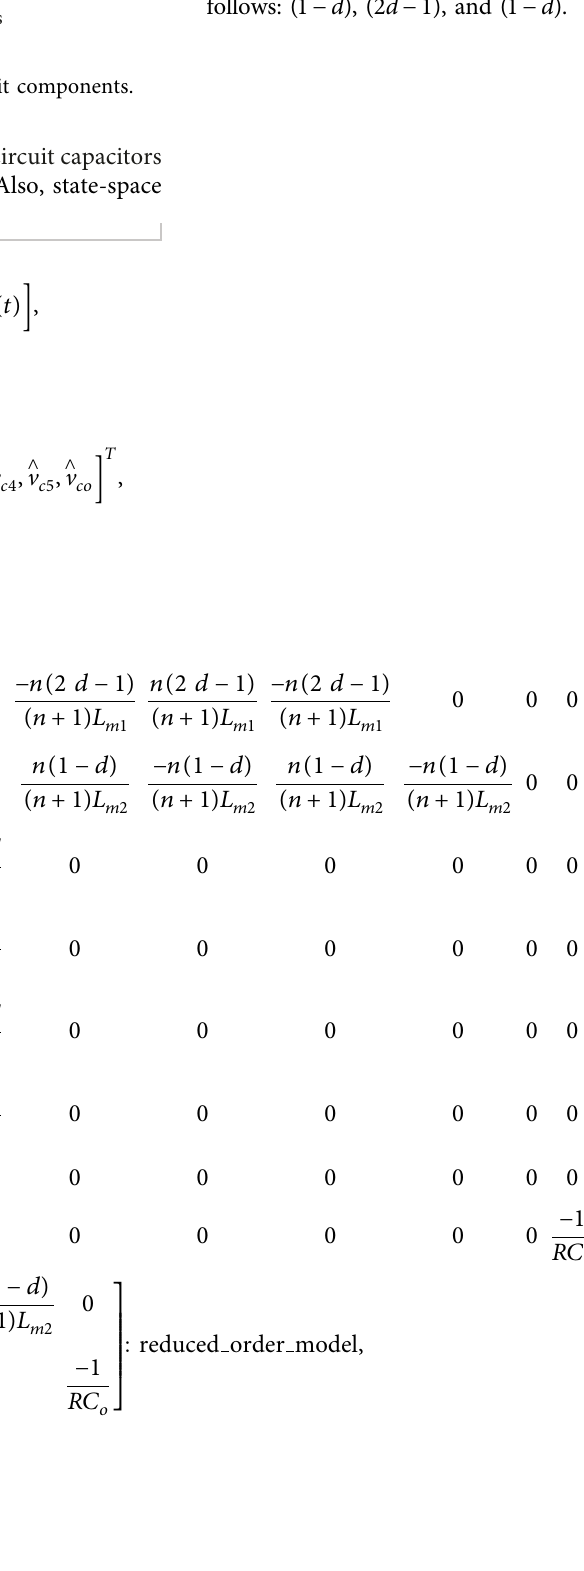
and S are in 1 2